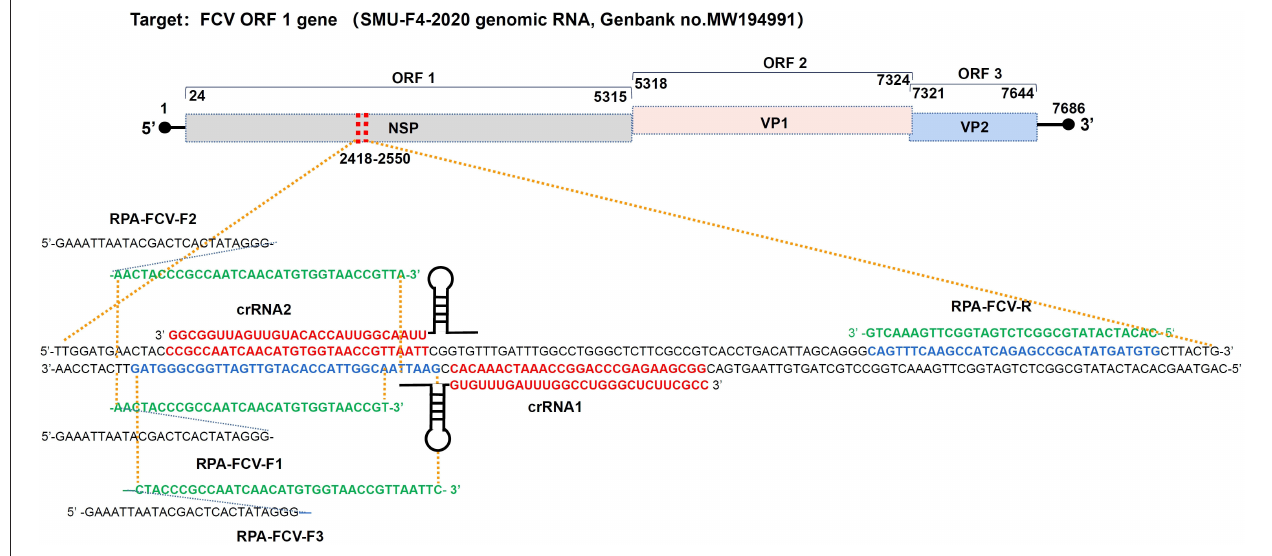
FIGURE 1 | Binding sites of RPA primers and crRNA oligonucleotides targeting to ORF-1 gene within the FCV genome map. crRNA1, crRNA2, and RPA primers were designed in positive and negative strands of the FCV ORF1 gene (from 2418-2550 nt), respectively, according to the conserved sequence of epidemic FCV strain SMU-F4-2020 from Southwest